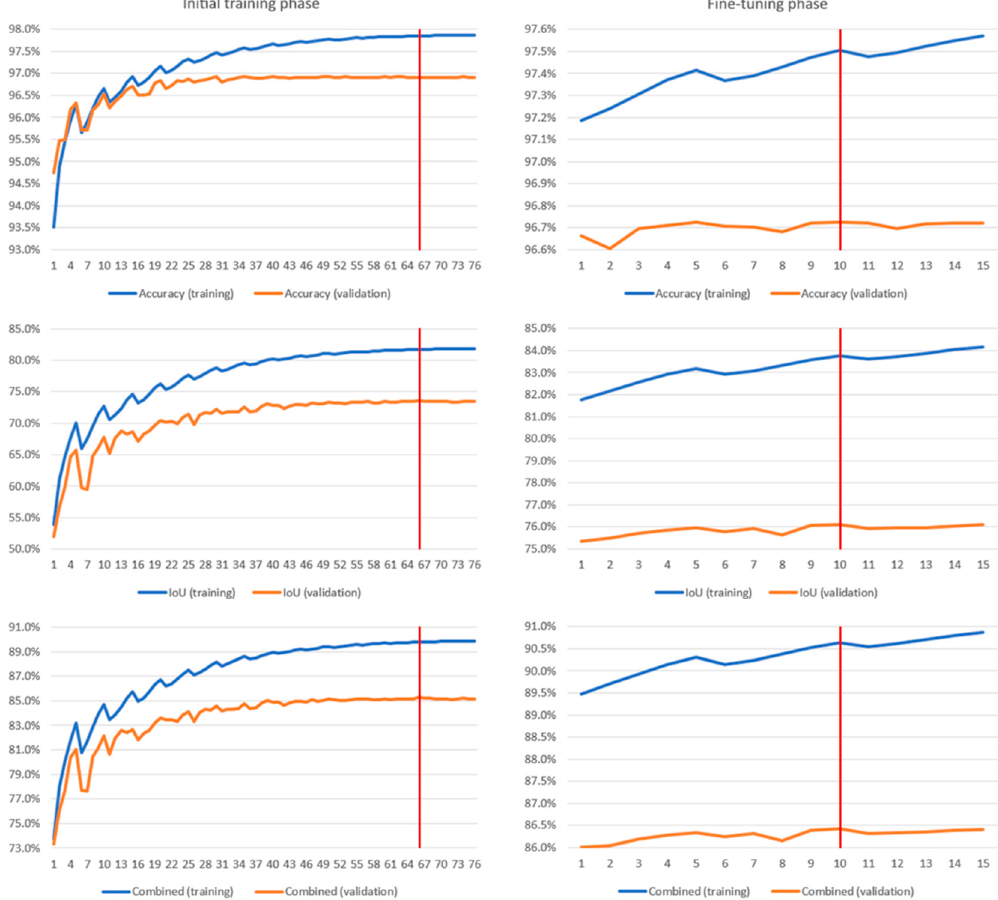
Figure 10. Accuracy, IoU, and combined metrics charts during the initial and fine-tuning training phase of the first model.